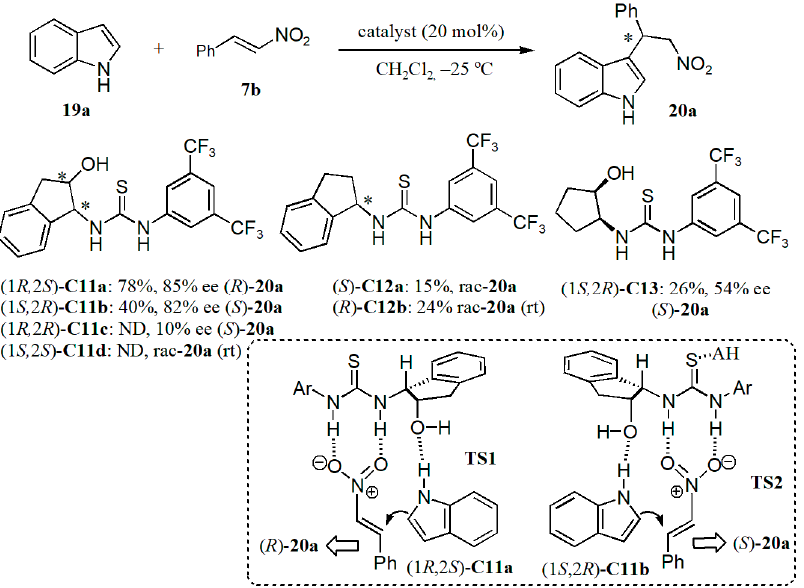
Figure 15. Thiourea-catalyzed Friedel–Crafts alkylation of indole 19a and the results obtained with catalysts C11–C13 [38–40]. AH = Brønsted acid additive.